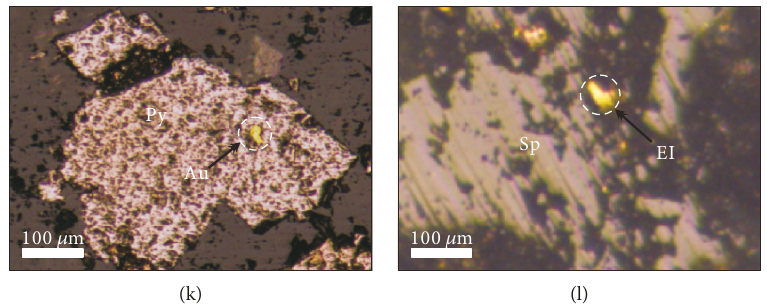
Figure 3: Photographs showing the alteration assemblage and ore minerals of the Xiejiagou gold deposit. (a) Potassic feldspathization and sericitization; (b) silici fi cation, sericitization, and pyritization; (c) silici fi cation and sericitization; (d) silici fi cation with rare carbonate alteration; (e) pyritization; (f) silici fi cation, sericitization, and chloritization; (g) euhedral cube pyrite in the early stage; (h) middle-stage pyrite occurs as subhedral aggregates; (i) middle-stage subhedral galena coexists with sphalerite and chalcopyrite; (j) middle-stage subhedral chalcopyrite coexists with pyrrhotite; (k) native gold occurs as inclusions in pyrite crystals; (l) electrum occurs as inclusion in sphalerite crystals. Kfs: K-feldspar; Ser: sericite; Chl: chlorite; Py: pyrite; Sp: sphalerite; Gn: galena; Ccp: chalcopyrite; Po: pyrrhotite;